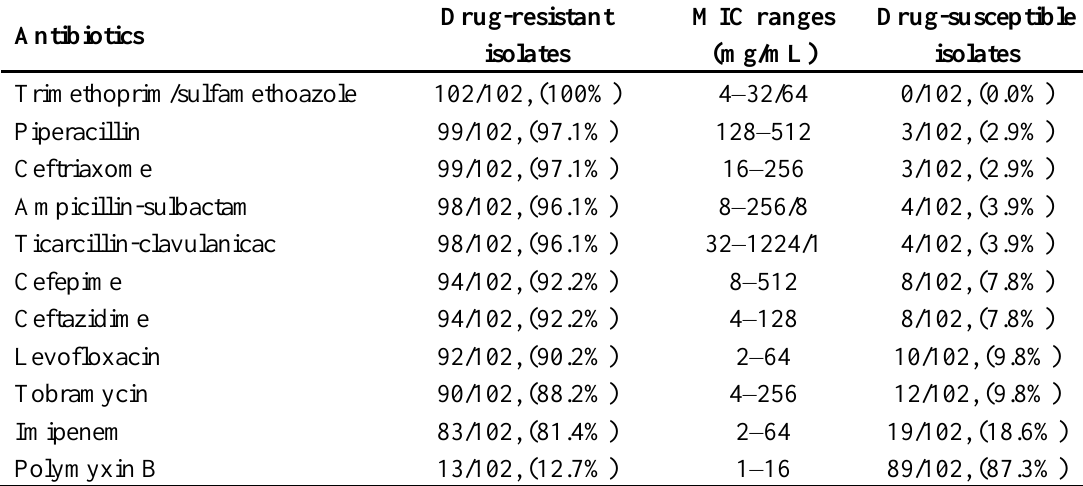
Table 2. The susceptibilities of clinical A. baumannii isolates to tested antibiotics (N = 102).